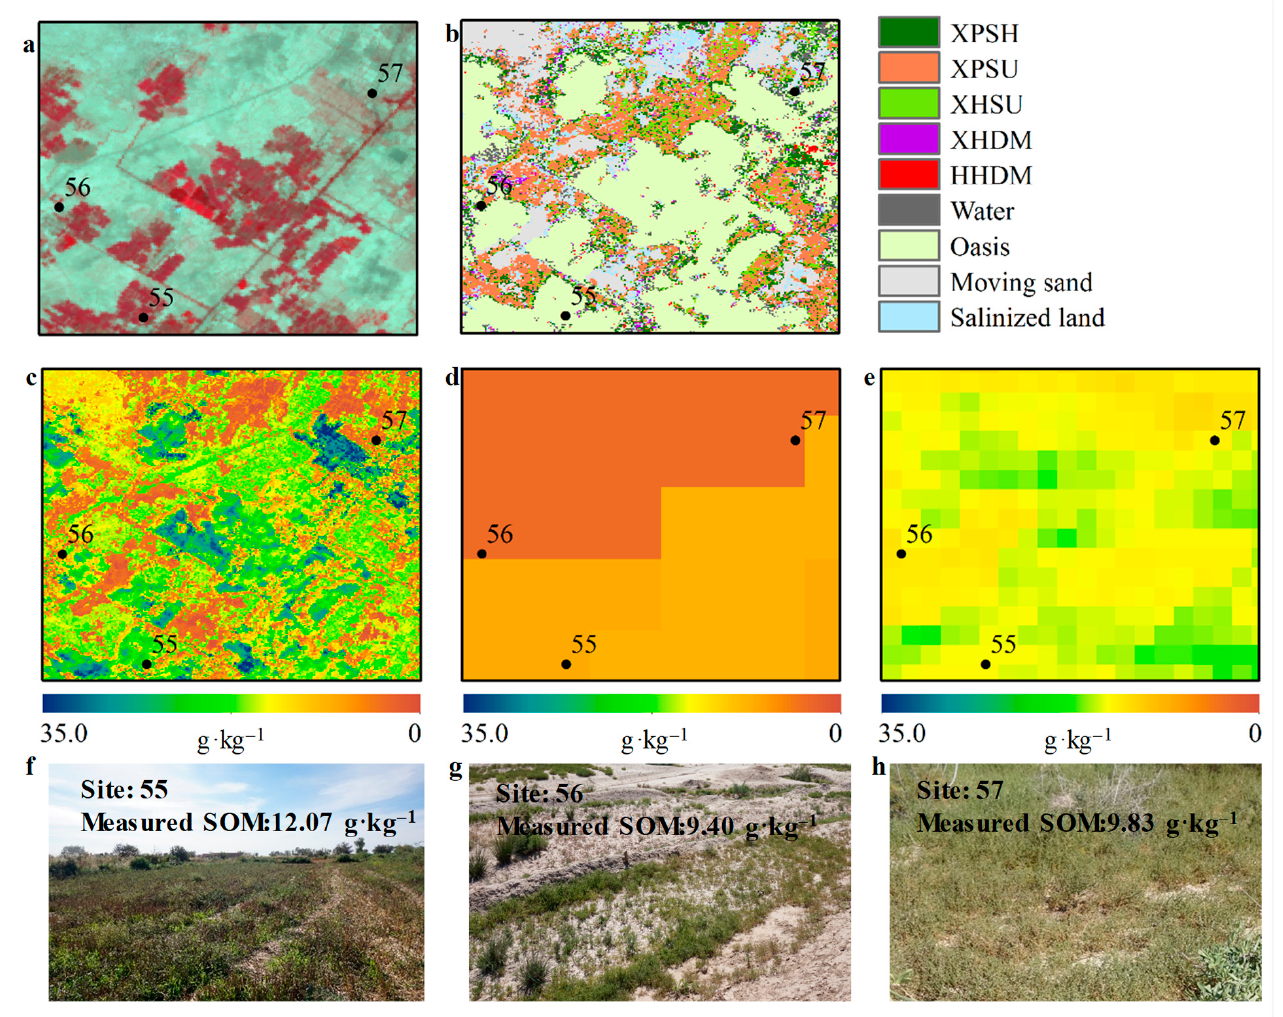
Figure 10. Comparisons with SOM datasets in the transitional zone between oasis and desert, assisted by landscape photos and measured SOM. ( a ) GF-1 WFV RGB composited image (bands 4, 3, and 2). ( b ) Map of desert vegetation-habitat complexes developed by [53]. ( c ) 16-m SOM dataset mapped in this study. ( d ) 30 × 30 arc-second resolution gridded SOM dataset developed by [20]. ( e ) SOM maps improved from SoilGrids SOC dataset at 250-m resolution, developed by [21]. ( f – h ) are landscape photos, and the corresponding measured SOM (upper right corner) for three sampling plots indexed by 55, 56, and 57, respectively.